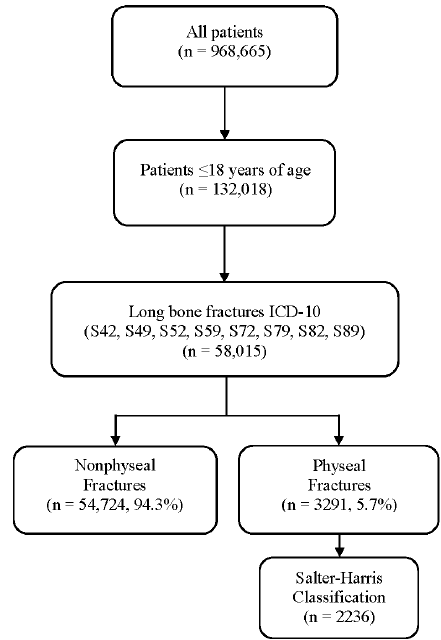
Figure 2. Flowchart of inclusion criteria using data from the NTDB.